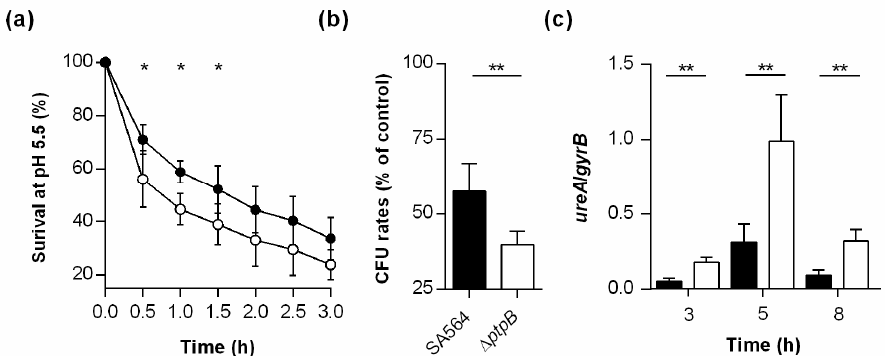
Figure 8. Effect of a ptpB deletion on the survival capacity of S. aureus at pH 5.5. Exponential growth phase cells of SA564 (black symbols) and its SA564 ∆ ptpB mutant (white symbols) were inoculated into PBS (pH 5.5) at an OD 600 of 1 and cultured for 3 h at 37 ◦ C. ( a ) Survival rates over time. Data are presented as mean ± SD of five biological replicates. ( b ) Relative CFU rates of the cultures after 1 h of incubation in PBS at pH 5.5. CFU rates are given in relation to the CFU rates determined in cell suspensions cultured for 1 h in PBS at pH 7.4. Data are presented as mean + SD of five biological replicates. ( c ) Quantitative transcript analyses of ureA in S. aureus cells grown in TSB at 37 ◦ C and 225 rpm to the time points indicated. Transcripts were quantified in reference to the transcription of gyrase B (in copies per copy of gyrB ). Data are presented as mean + SD of five biological replicates. * p < 0.05; ** p < 0.01 (Mann-Whitney U test between WT and mutant at a given time point).